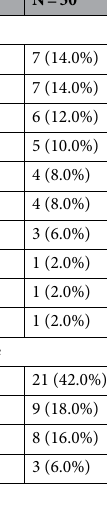
Table 3. Gene mutation profiles of the 50 most recent